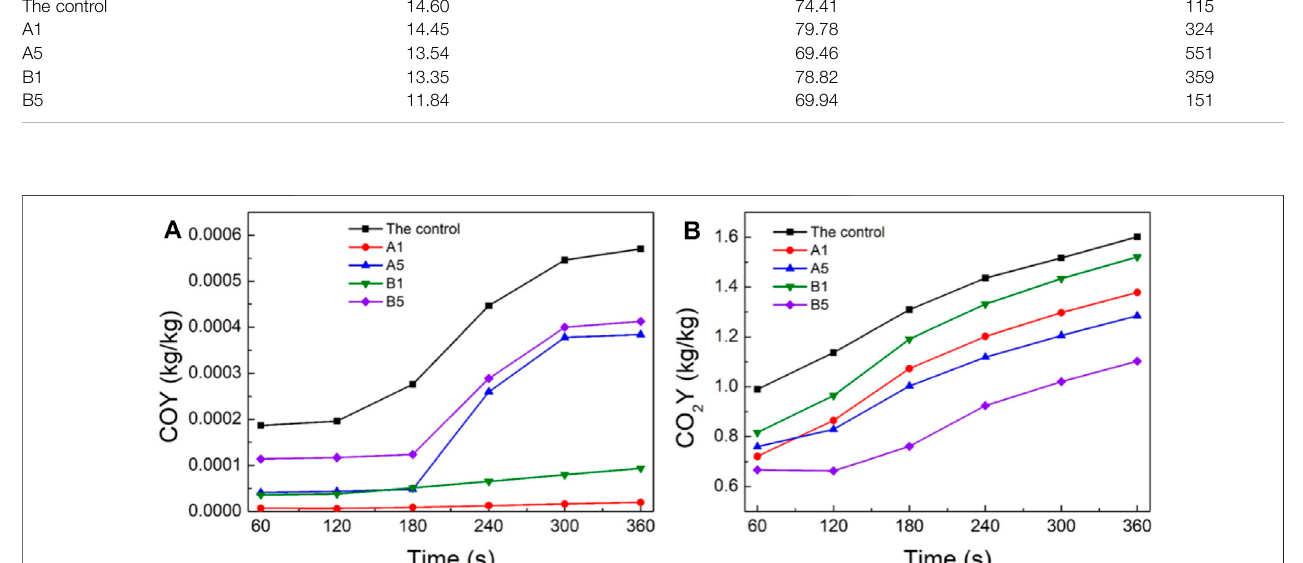
FIGURE 9 | COY (A) and CO 2 Y (B) of bamboo specimens before and after LbL self-assembly with PA-PEI in initial 360 s.